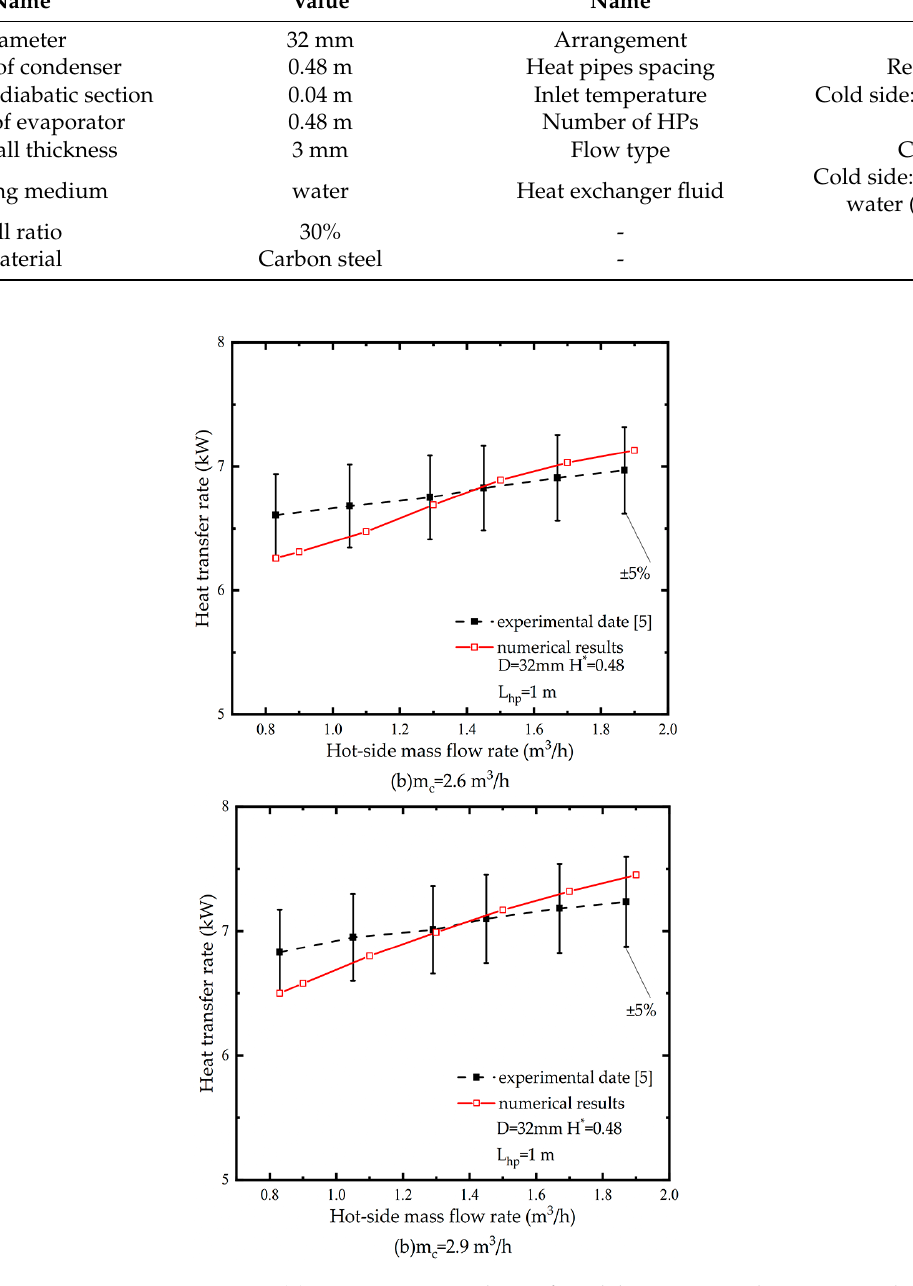
Figure 5. (a) Comparative analysis of model structure and experimental data under cold fluid inlet m = 2.6. (b) Comparative analysis of model structure and experimental data mass flow rate of m c = 2.6. ( b ) Comparative analysis of model structure and experimental data under mass flow rate of c cold fluid inlet mass flow rate of 2.9 m 3 under cold fluid inlet mass flow rate of 2.9 m3/h.